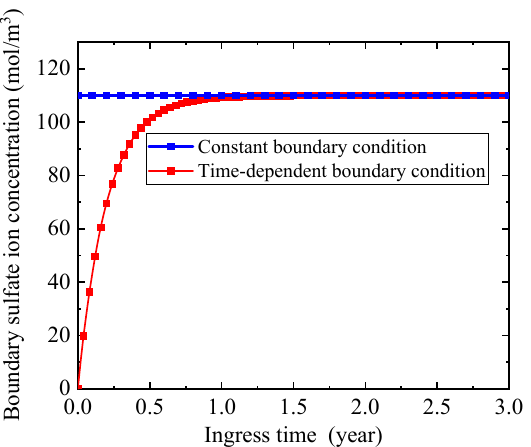
Figure 16. Sulfate ion concentration on the ingress surface.